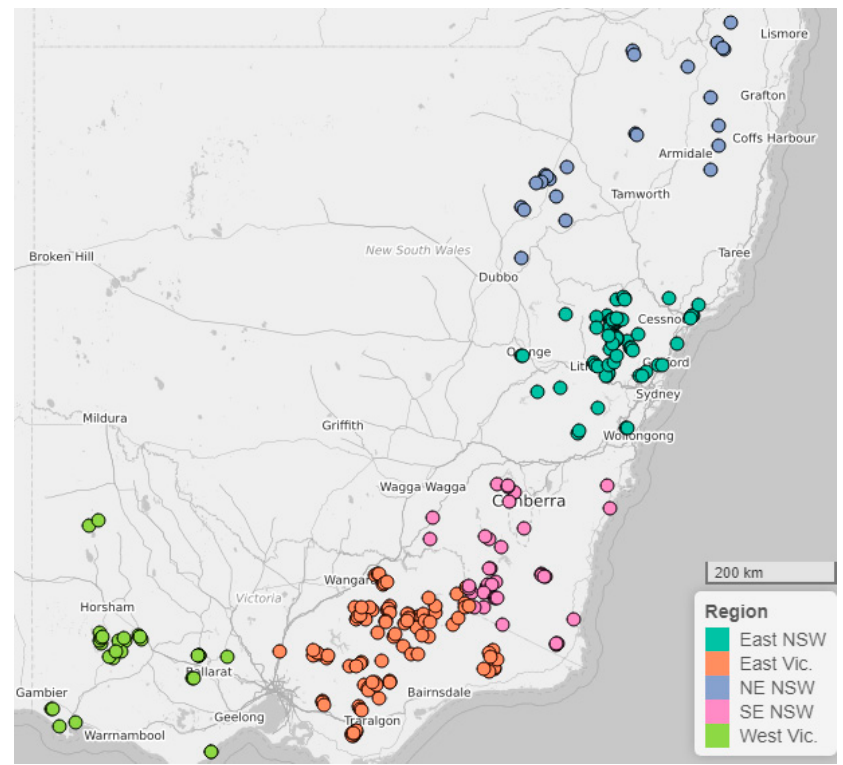
Figure 1. Locations of source fires captured and analysed for this study, coloured by assigned region. Base-map © OpenStreetMap contributors .